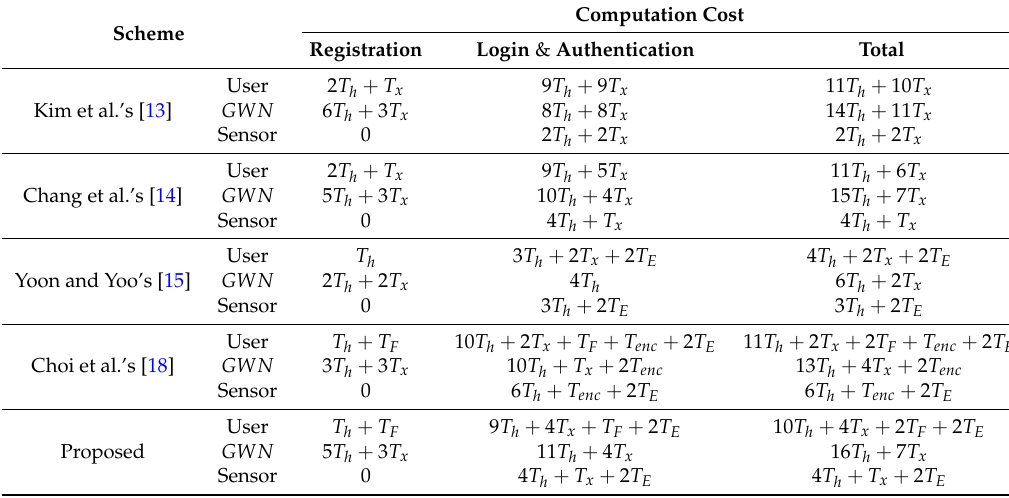
Table 4. Comparisons of the computation